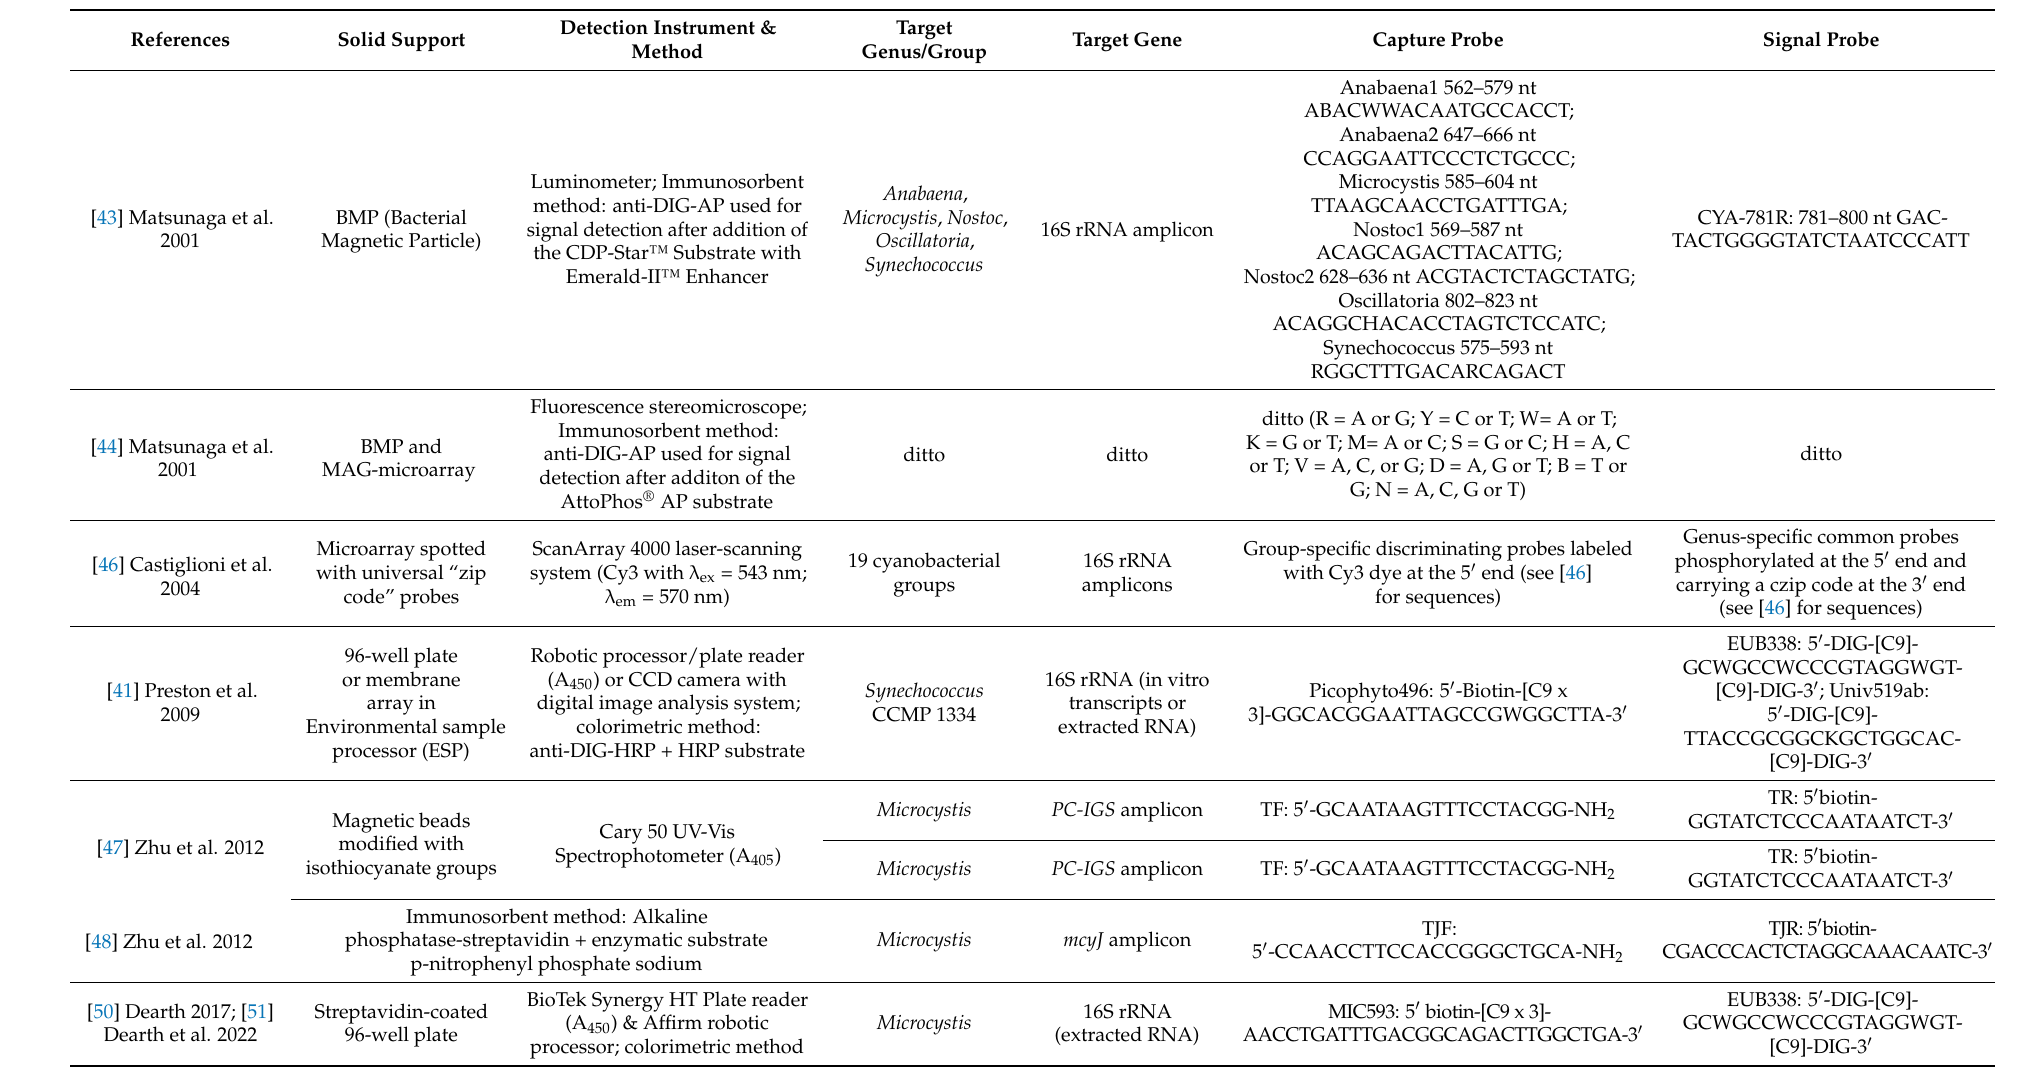
Table 2. Published studies of SHA application to cyanobacteria detection and